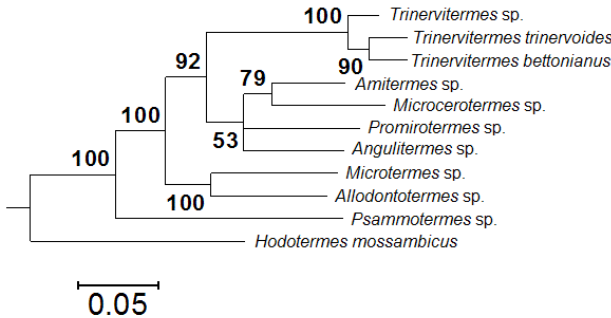
Fig 2. Input Bayesian phylogeny for Phylocom based on the gene cytochrome oxidase II using Mr Bayes v3.1.2. Analysis was done with 10 7 generations, as well as a number of chains=4, sample frequency=1000 and a finalizing burn-in of 2500.